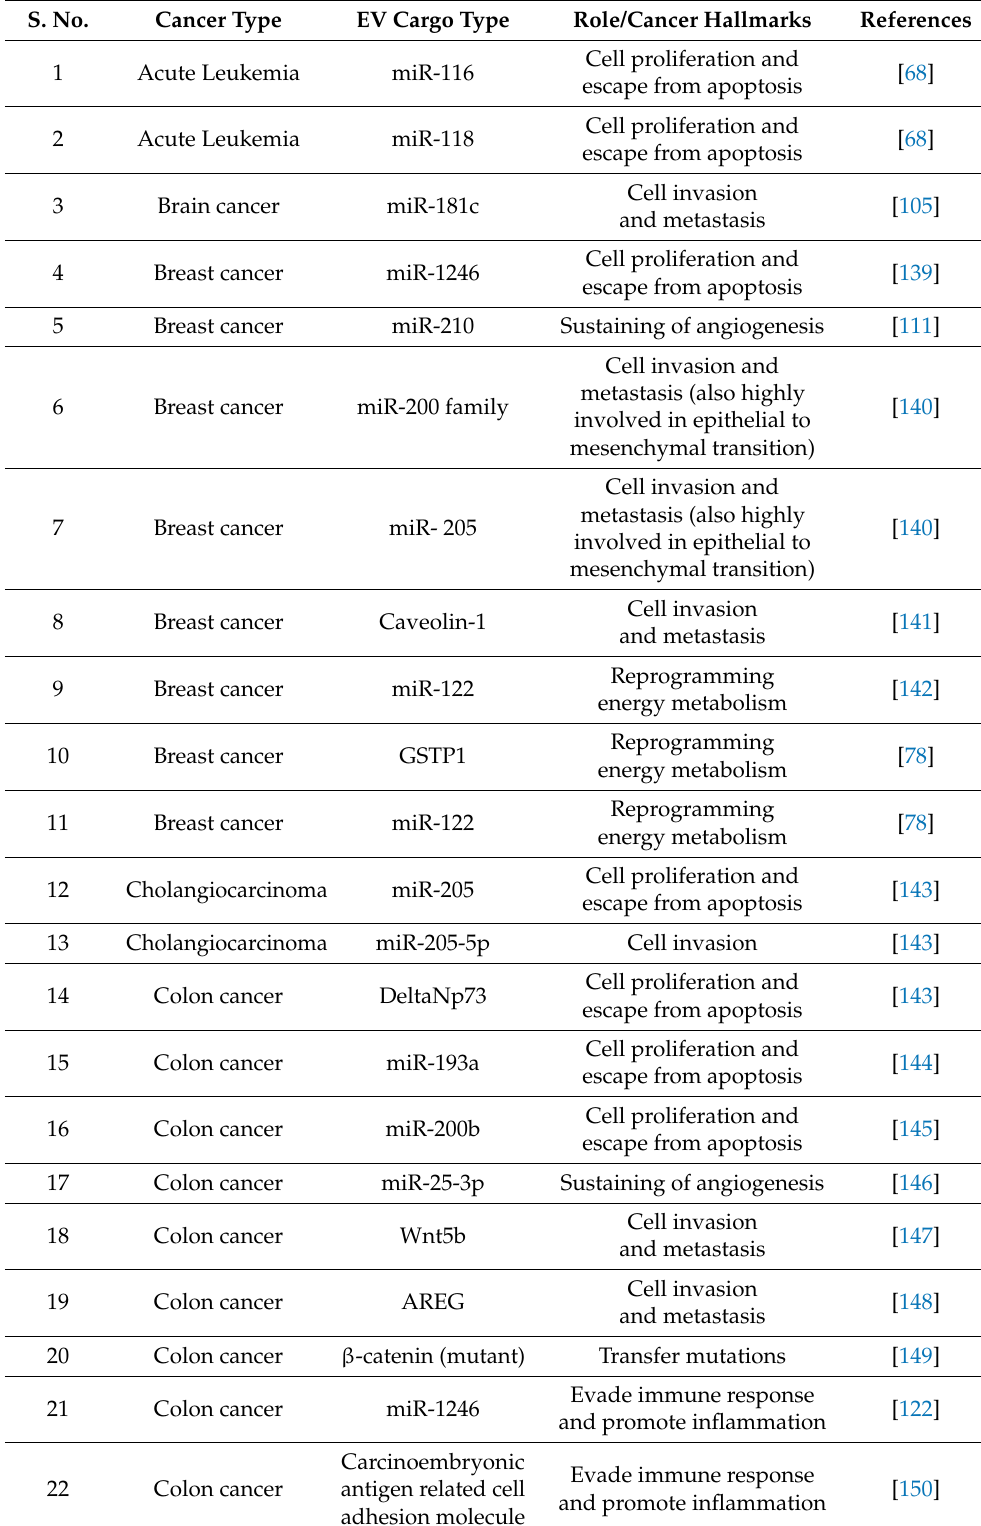
Table 2. List of cancer types and released EVs cargo and their role in cancer hallmarks. S.